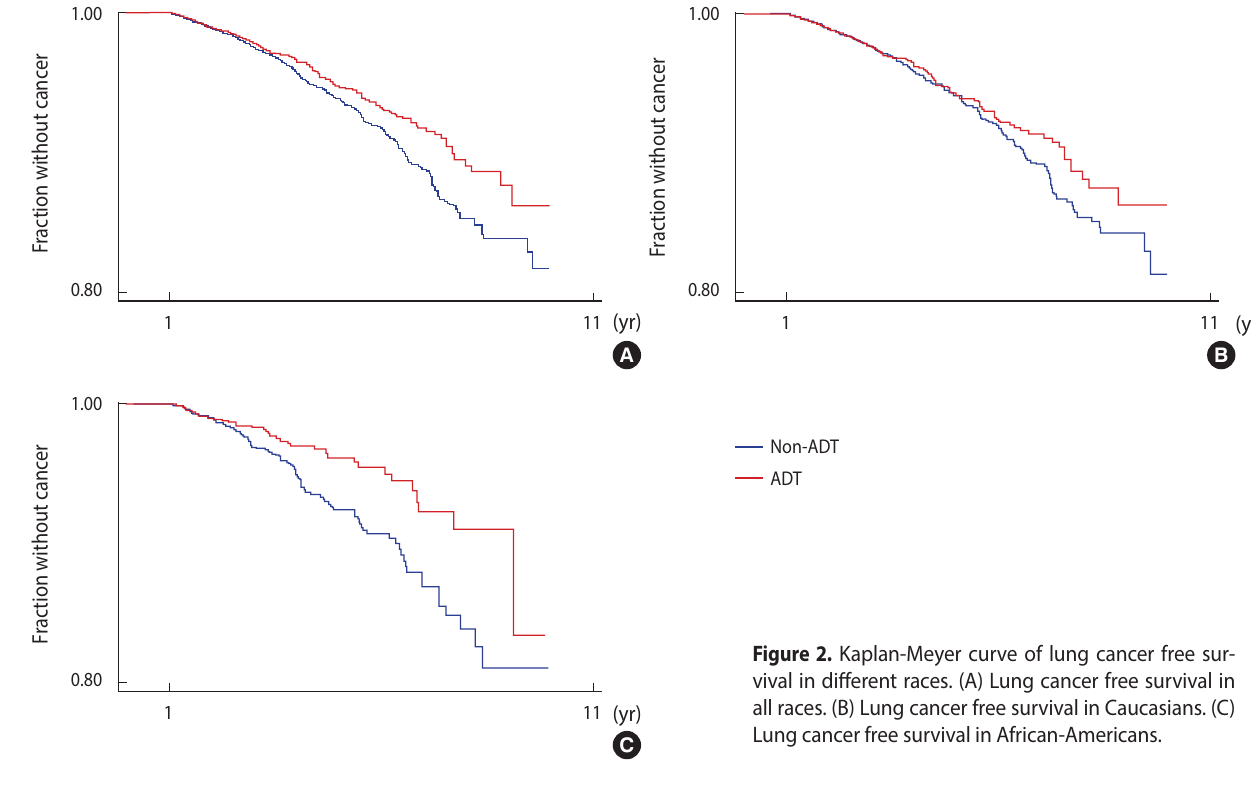
Table 3. HRs of ADT for different types of lung cancer by race Race SCLC p-value NSCLC p-value All types p-value Caucasians 1